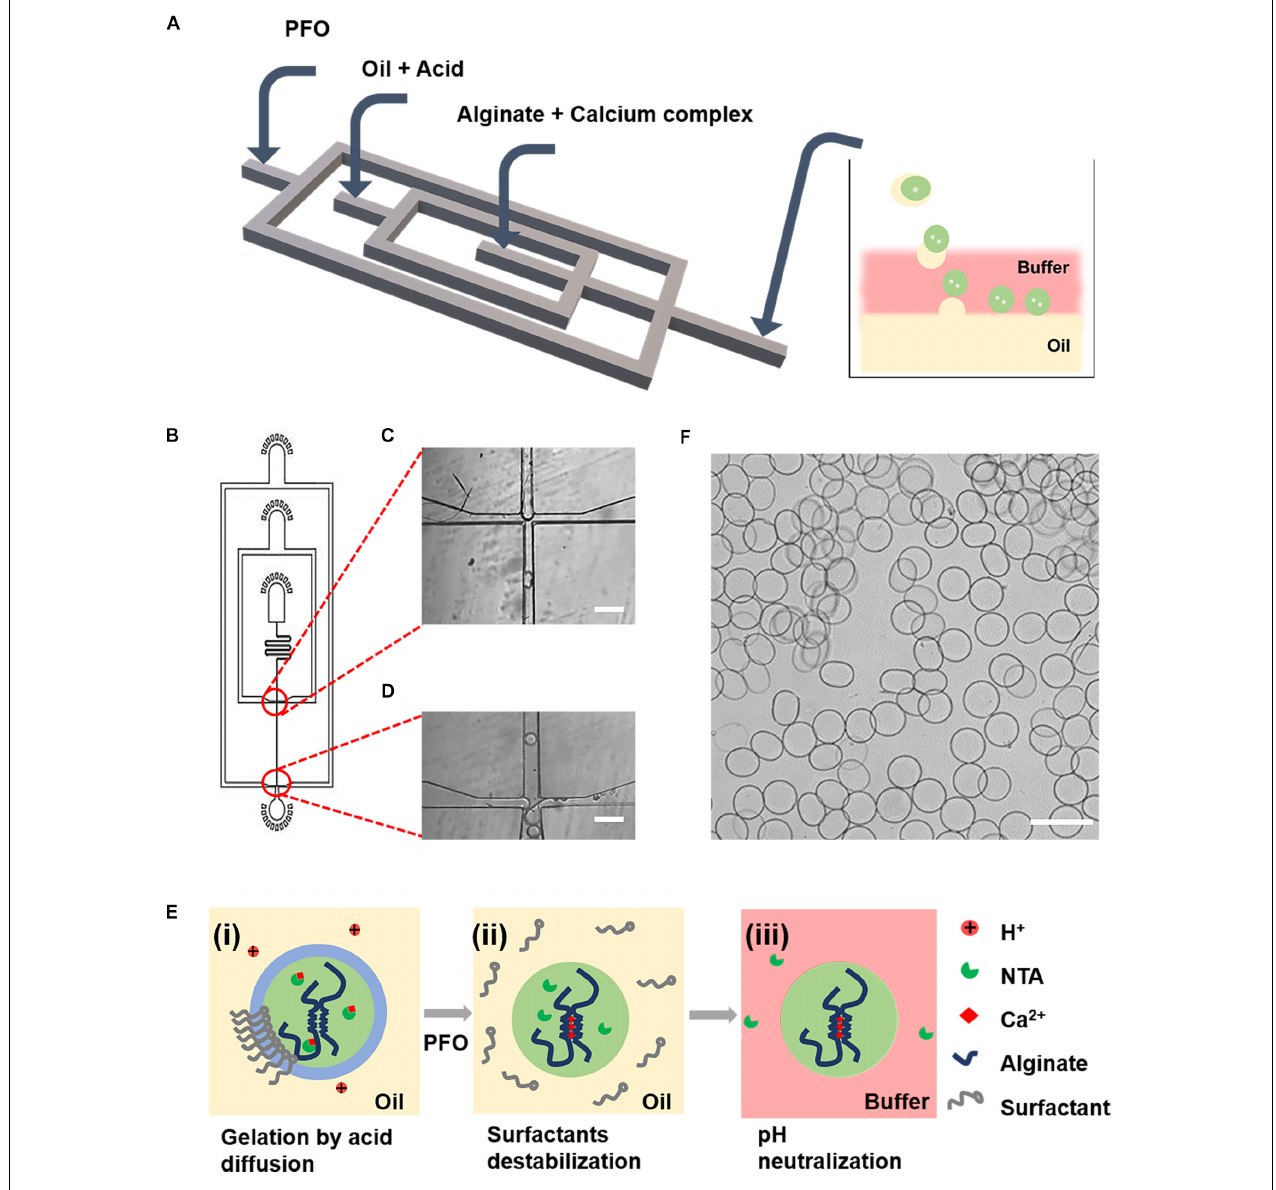
FIGURE 1 | Microfluidic generation of alginate gelation by on-chip release of calcium ions from a water-soluble calcium complex as the crosslinker. (A) Schematic illustration of the design of the PDMS device for the generation of cell-laden alginate microgels. (B) AutoCAD design of the microfluidic device for continuous generation of cell-laden microgels. (C,D) Microscopic images of the microchannels showing the flow-focusing drop-maker (C) and the cross-junction for adding of PFO (D) . (E) Schematics showing the formation mechanism of alginate microgels. (i) Flow-focusing junction breaking up the lamellar flow into droplets. The acetic acid in the oil phase diffused into the aqueous droplet, which triggered the release of Ca 2 + ions from calcium complex conjugates and induced the gelation of alginate. (ii) The stability of the oil–water interface was broken by PFO. (iii) Microgels were immediately transferred from the oil to an aqueous phase consisting the buffer until the pH of microgels was neutralized. (F) Microscopic image showing the resulting alginate microgels. Scale bar is 100 µ m.